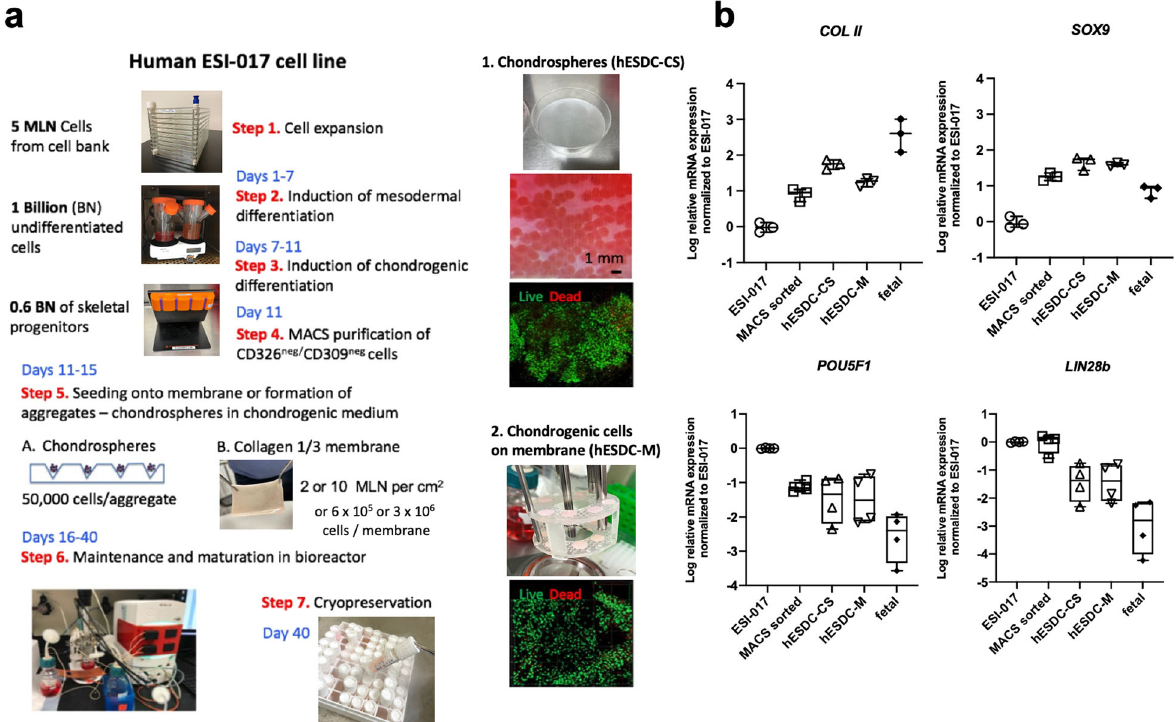
Fig. 1 Scale up and formulation of cGMP-grade hES-derived chondrocytes. a Schematic depicting the large-scale production of chondrocytes in 2 different formulations from ESI-017 cells. Pre-chondrocytes were seeded onto clinically-used porcine collagen I/III membranes (M) or aggregated to generate chondrospheres (CS). Cells were expanded and then cryopreserved under optimal conditions described in Supplementary Fig. 1. b qPCR for chondrogenic and pluripotent genes at different stages of in vitro differentiation or in vivo fetal ontogeny (14 – 17 weeks). n = 3 – 4 different batches or biological replicates (fetal); data presented as box and whisker plots showing all